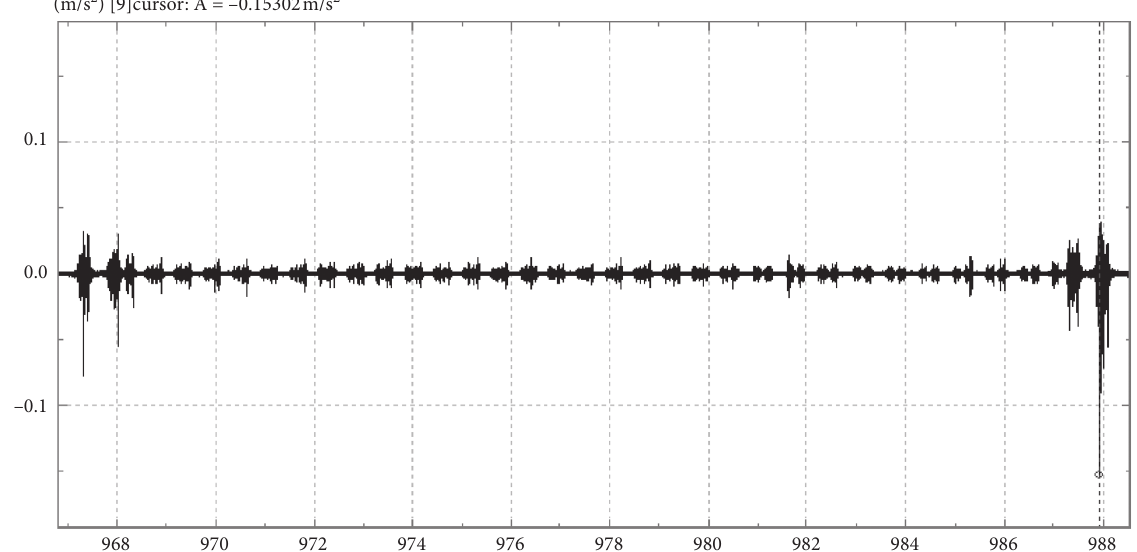
Figure 21: Time domain characteristic diagram of vibration acceleration along the line perpendicular direction ( X -axis) in the repair zone.